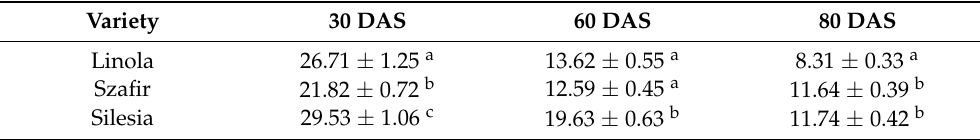
Table 2. Chlorophyll mg/gDW (sum chlorophyll a and b) in leaves at different growth stages. 30 DAS—vegetative growth, 60 DAS—flowering, 80 DAS—setting and growth of seed capsules. DAS—day after sowing. All results are statistically significant ( p < 0.05) Different superscripts imply significant